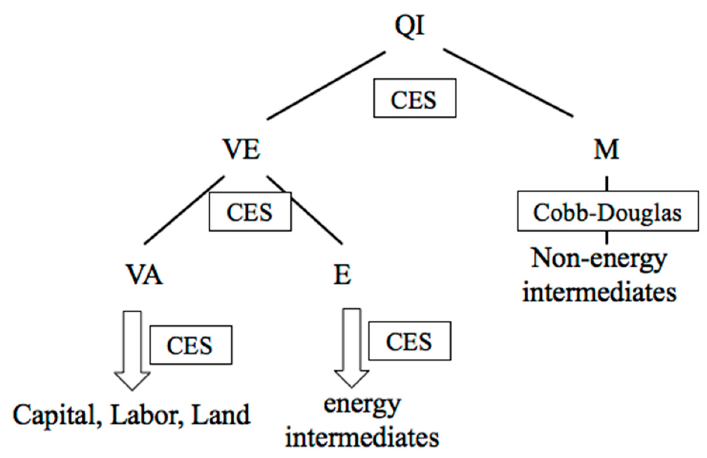
Figure A1. Production structure.